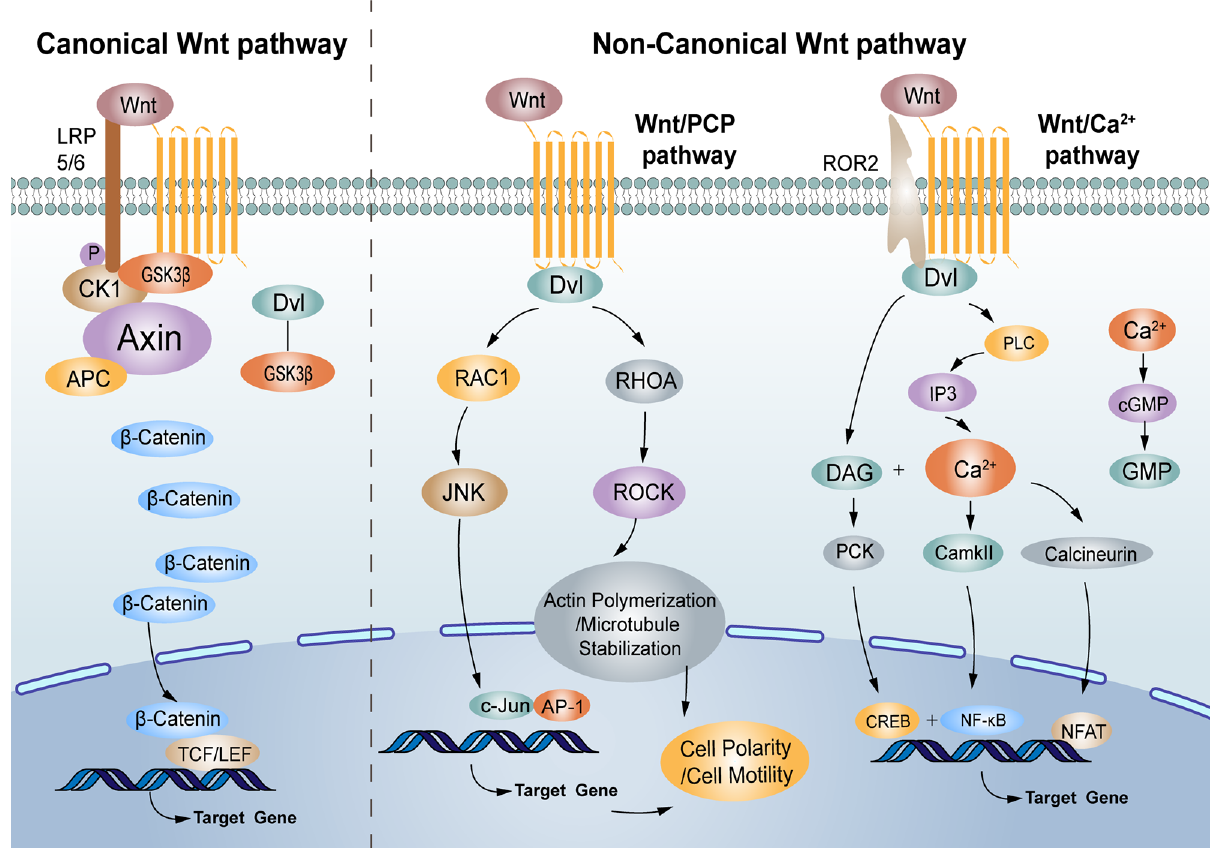
Figure 1. The canonical and non-canonical Wnt signalling pathway.